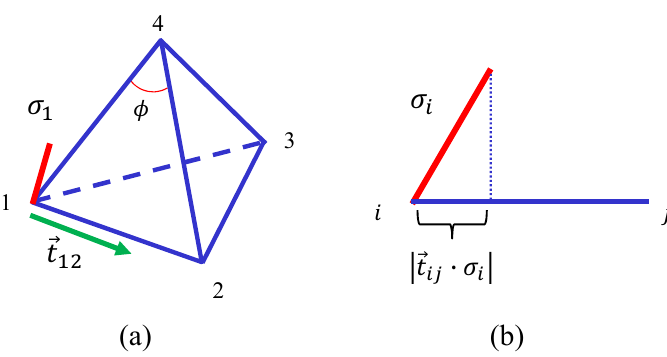
Figure 3. ( a ) A tetrahedron, which forms lattices for the simulation, and a variable σ 1 at the vertex 1, and ( b ) the tangential component | t ij · σ i | of σ i along the bond ij